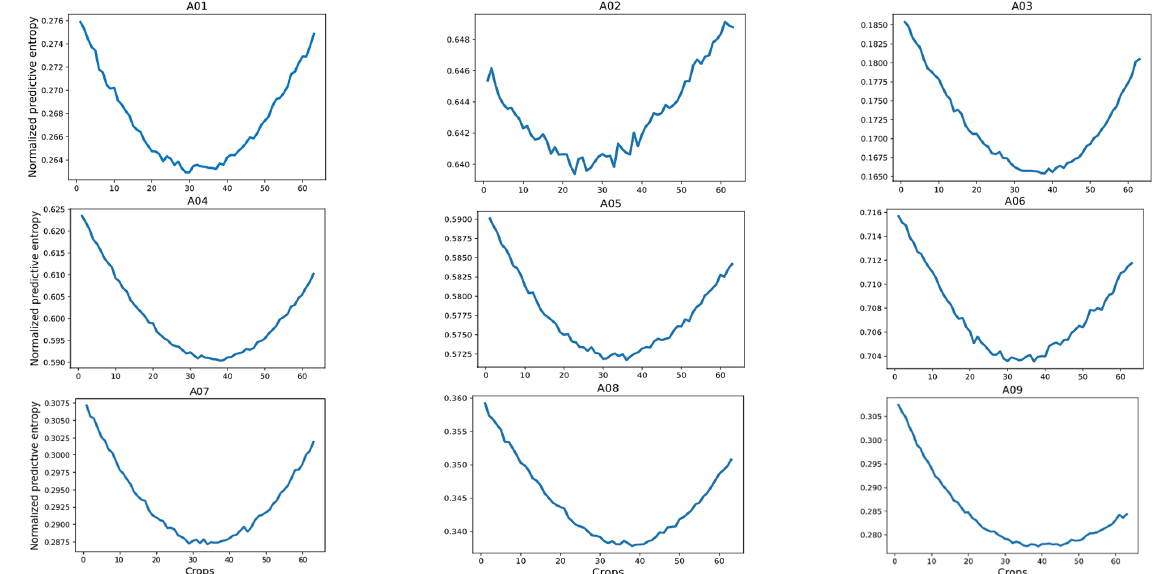
Figure 7. Average of the normalized predictive entropy for each crop on subjects in dataset 2a.